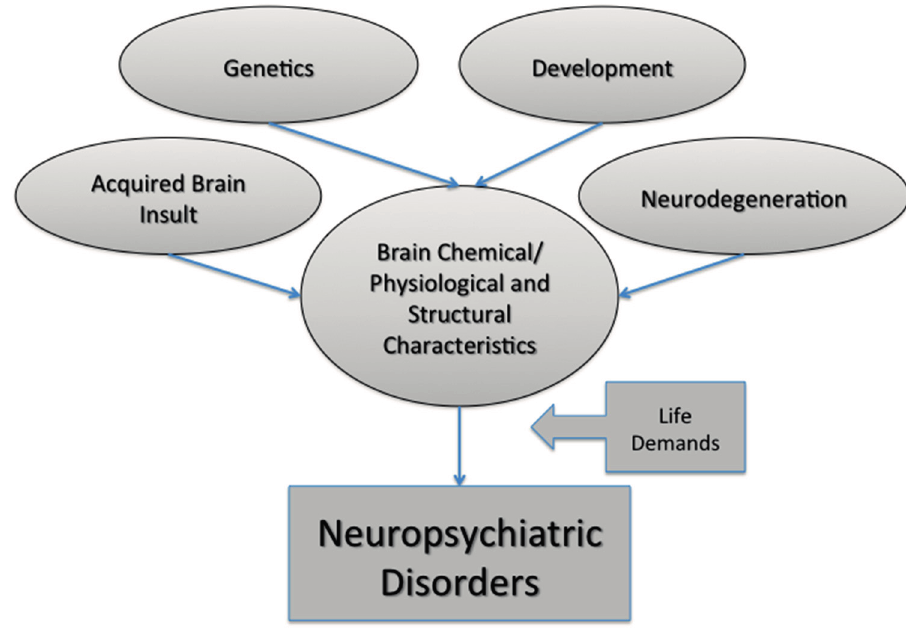
Figure 1. Multiple factors contribute to neuropsychiatric disorder susceptibility. These factors include genetic predisposition, developmental insult, brain injury and natural (or disease-state) aging. Together these factors can influence the molecular, physiological and structural characteristics of the brain. Environmental (or external) factors, such as the demands of life, loss of a loved one or experiencing abuse can also have a negative impact on brain health. Taken together, neuropsychiatric disorder development is extremely cofounded with multiple variables, resulting in individualized trajectories to the same end point: a neuropsychiatric